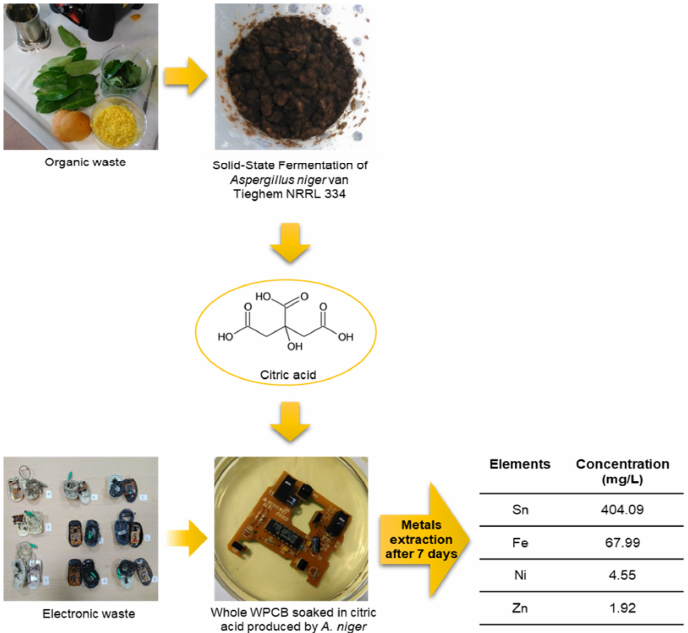
Figure 1. Schematic representation of the experimental design.